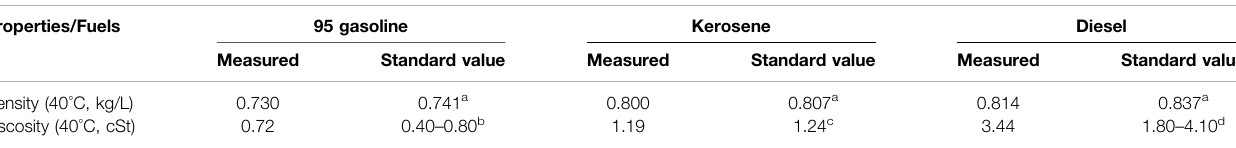
TABLE 1 | Fuel properties compared with standard values. Properties/Fuels